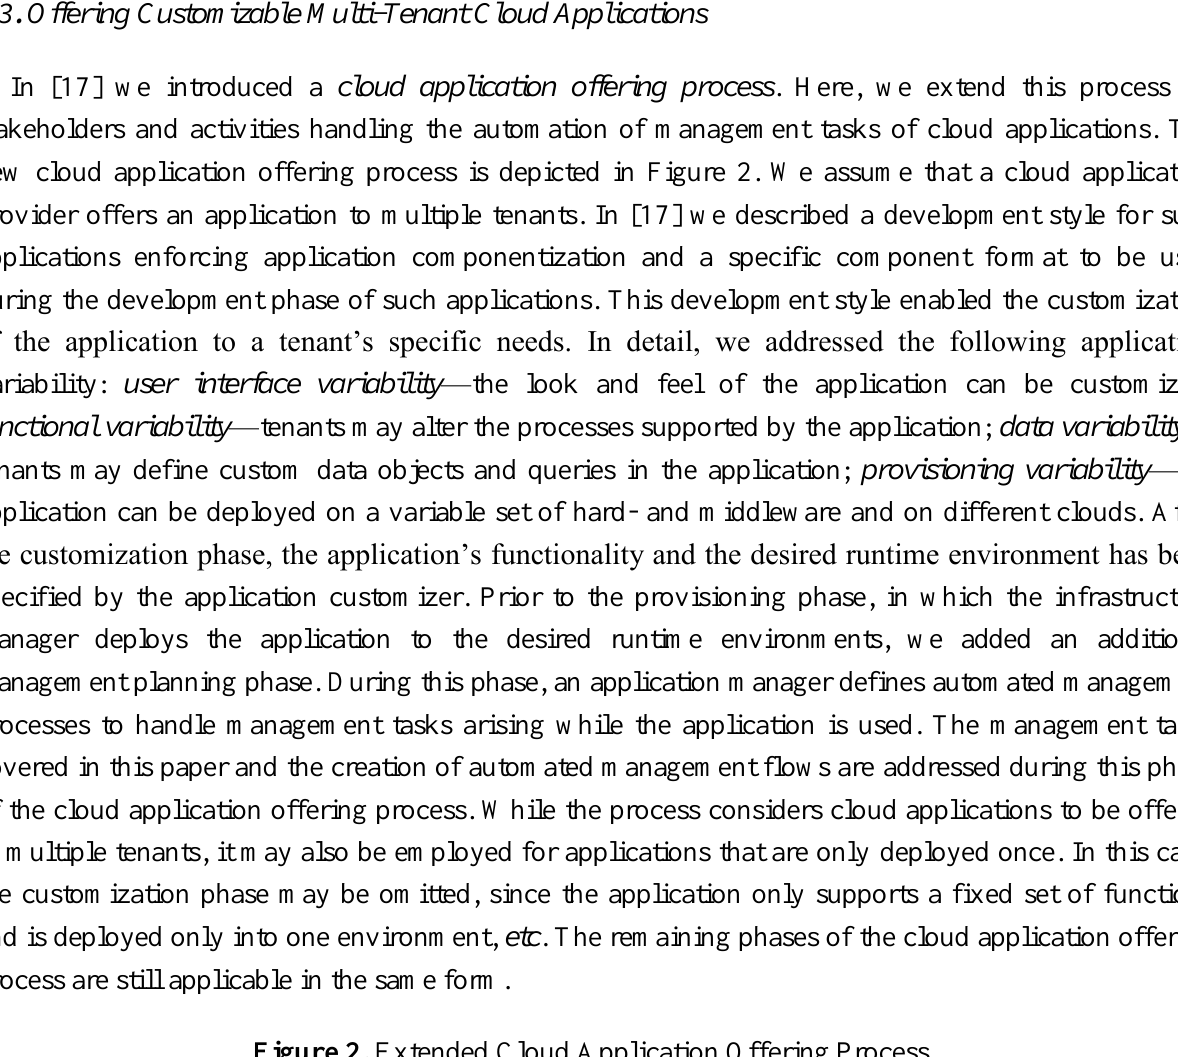
Figure 2. Extended Cloud Application Offering